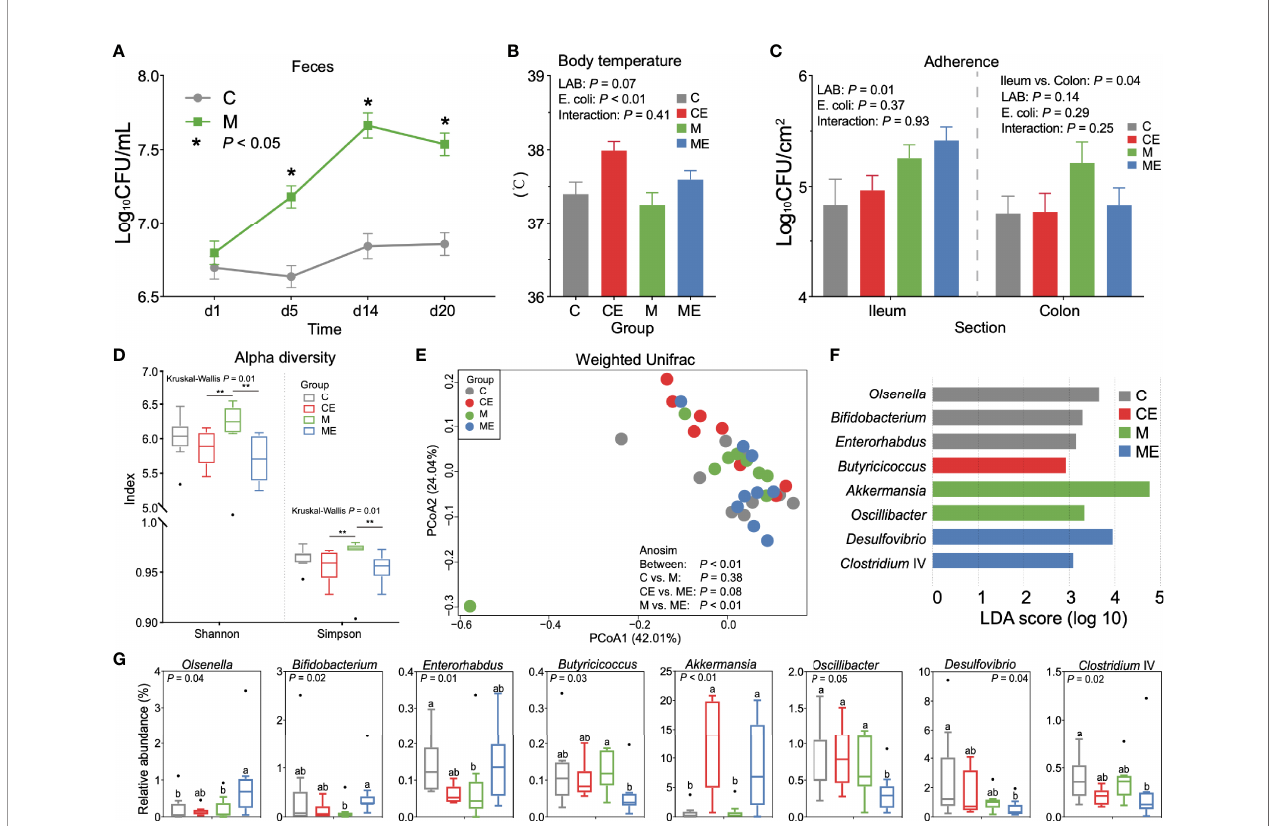
FIGURE 3 | Gut microbiota pro fi les in mice fed with mixed LAB strains and challenged with Escherichia coli . (A) Counts of LAB in feces of mice fed with mixed LAB strains (M) and control group (C) at days 1, 5, 14, and 20. (B) Body temperature of control mice (C), control mice challenged with Escherichia coli (CE), mice fed mixed LAB strains (M), and mice fed mixed LAB strains and challenged with Escherichia coli (ME) at the end point. (C) Adherence of LAB in the ileum and colon of mice between C, CE, M, and ME groups. (D) Alpha diversity (Shannon and Simpson index) of gut microbiota in mice between C, CE, M, and ME groups. (E) Principal coordinate analysis (PCoA) on the weighted UniFrac distance matrix of gut microbiota between C, CE, M, and ME groups. (F) Linear discriminant analysis (LDA) score of gut microbiota (with LDA score > 2) at the genus level between C, CE, M, and ME groups. (G) Relative abundance of bacteria genera with LDA score > 2 between C, CE, M, and ME groups. * p < 0.05, ** p < 0.01. Letters a,b in the same graphic were signi fi cantly different ( p <